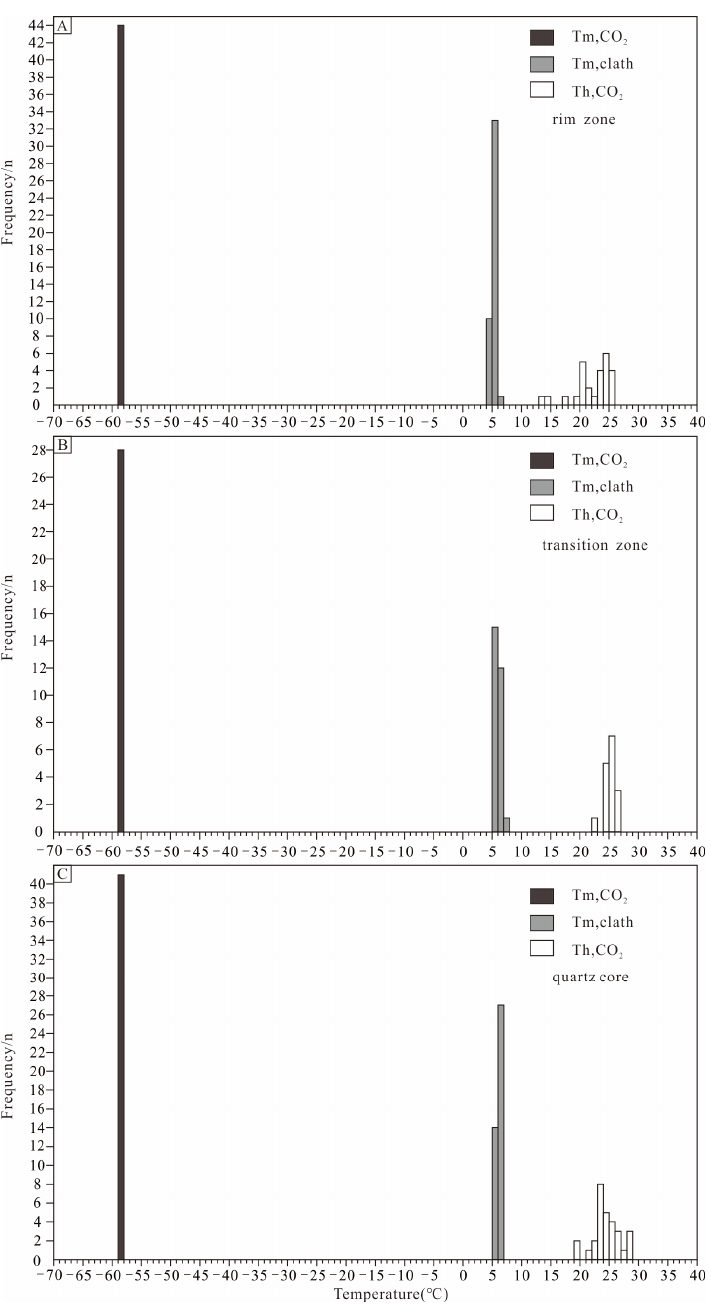
Figure 8. Histograms of CO 2 melting temperatures, clathrate melting temperatures, and CO 2 partial homogenization temperatures of type I a and type I b inclusions in Dakalasu No. 1 pegmatite vein. ( A ) Type I a and type I b inclusions in the rim zone; ( B ) type I a and type I b inclusions in the transition belt; ( C ) type I a and type I b inclusions in the quartz belt.